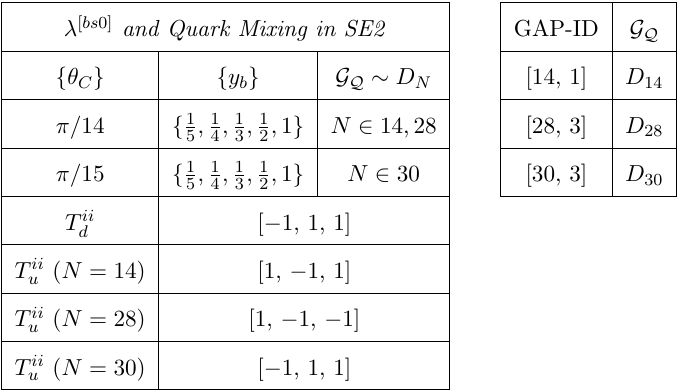
Table 11 . Flavour symmetries G Q controlling the simpli(cid:12)ed (cid:21) [ bs 0] pattern and U c quark mixing in